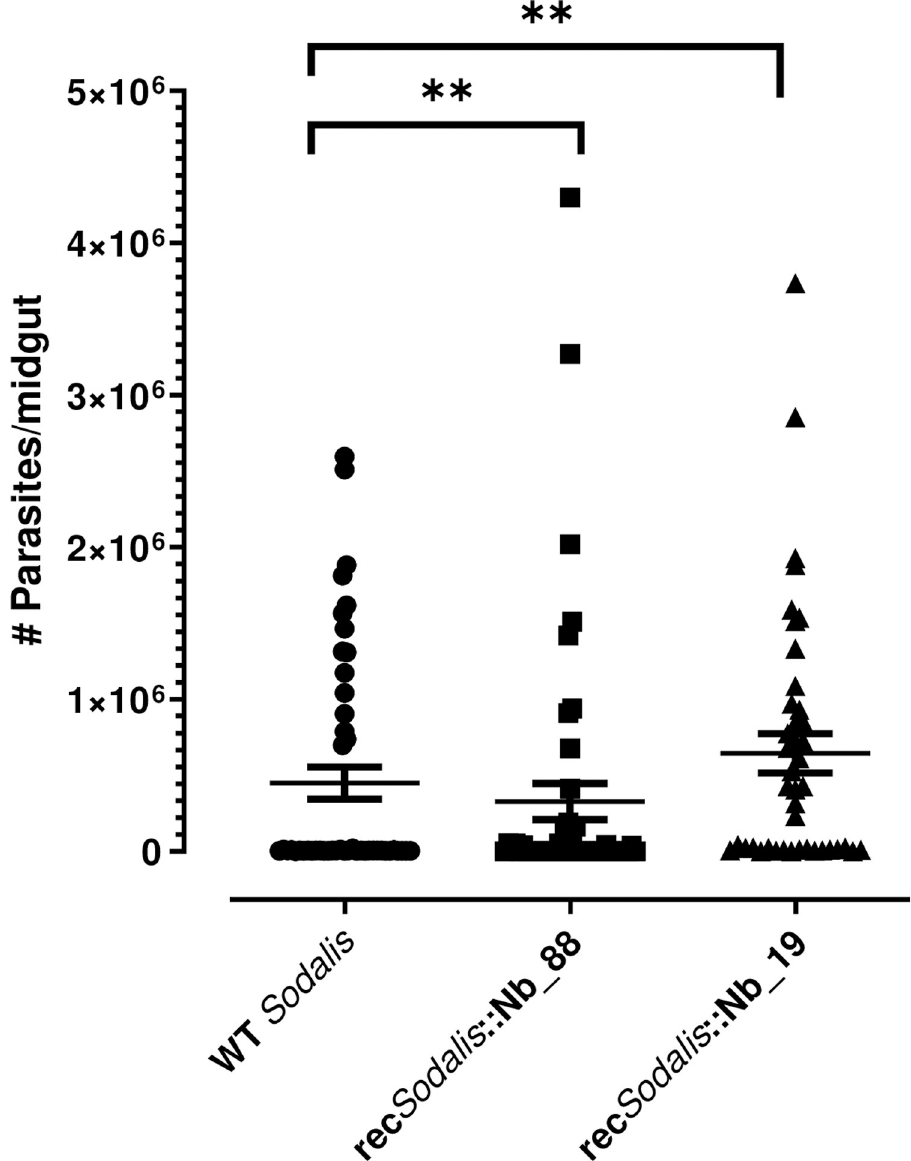
Fig 4. Influence of recombinant S . glossinidius expressing Nb_88 and Nb_19 on midgut parasite densities determined by trypanosome-specific qPCR. p values were obtained by comparing the infection prevalence of the WT S . glossinidius (n = 48) harbouring group to the infection prevalence of either rec Sodalis ::Nb_88 (n = 50) or rec Sodalis ::Nb19 (n = 42) harbouring flies using a two-tailed Mann Whitney test. Error bars represent mean with standard error of the mean (SEM) and are based on at least two independent